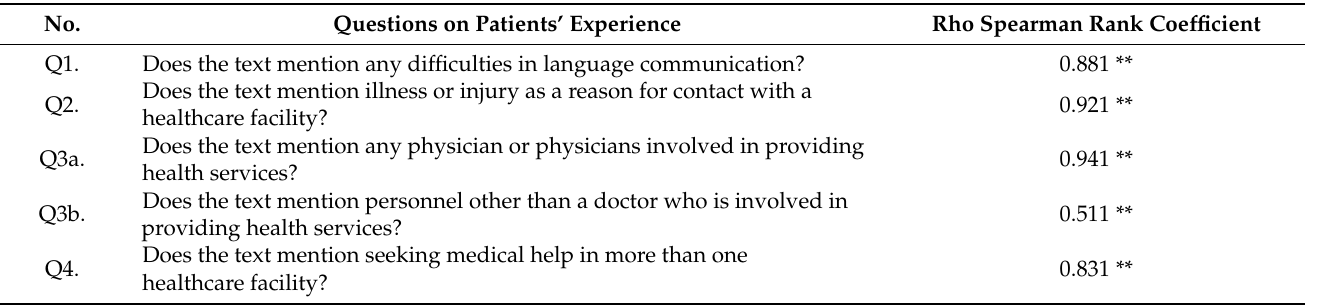
Table 3. Correlations of Python script and single-variable ranked readers’ classifications for five questions on patients’